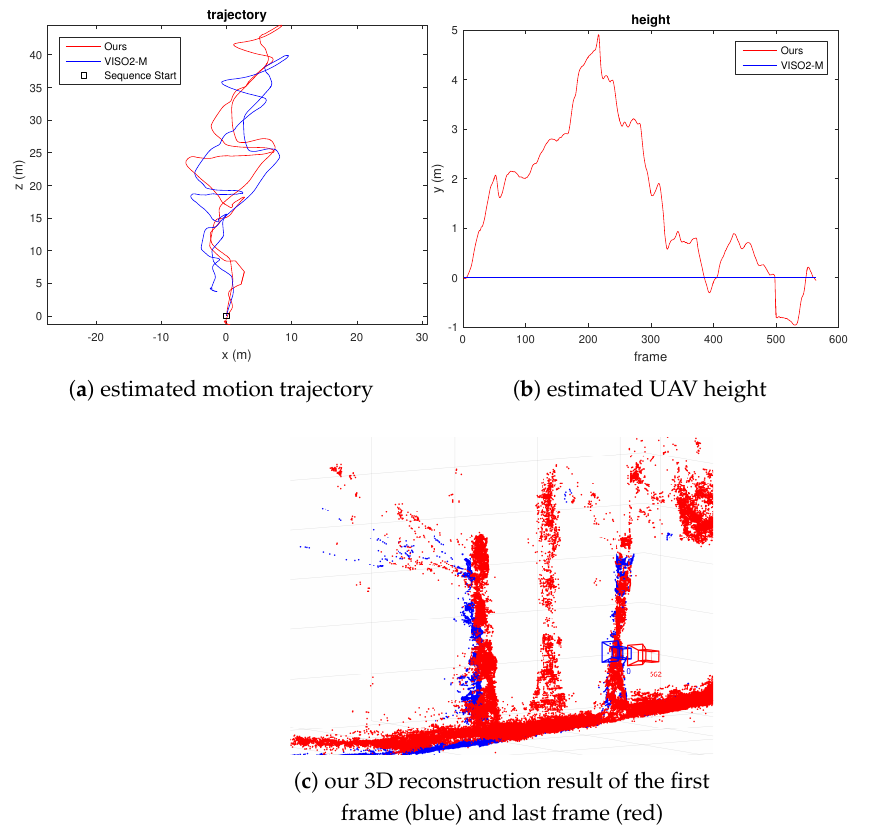
Figure 9. Fast-moving UAV video result, where the initial height is defined as 0 m in ( b